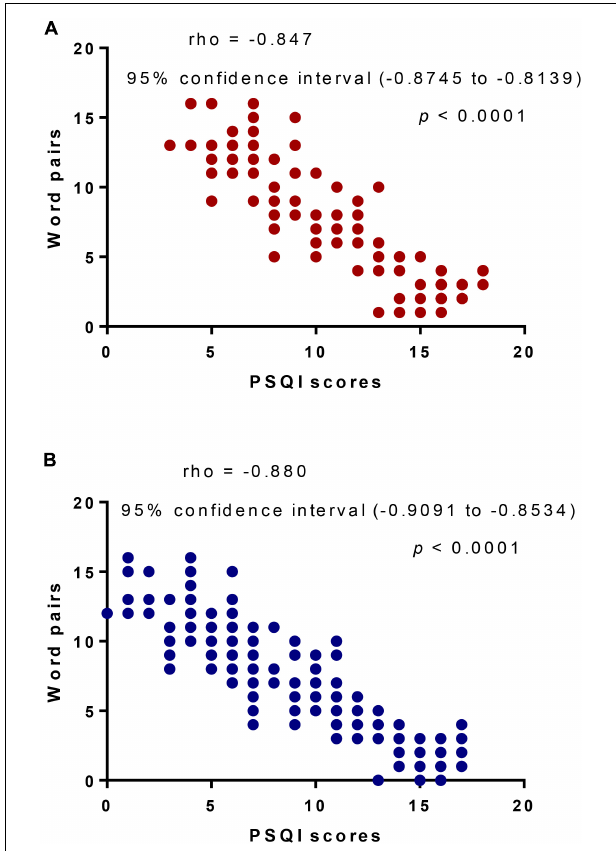
FIGURE 3 | The analysis of Pearson correlation coefficients between PSQI scores and word pairs. (A) Unadjusted analysis. (B) Adjusted analysis. Adjusted Cox proportional hazards models to assess the association between word pairs and PSQI scores by baseline PSQI, including age, gender, high blood pressure, high blood lipids, diabetes, overweight, AFAS, smoking and family history of stroke. There will be a strong negative relation if rho value falls within -0.5 and